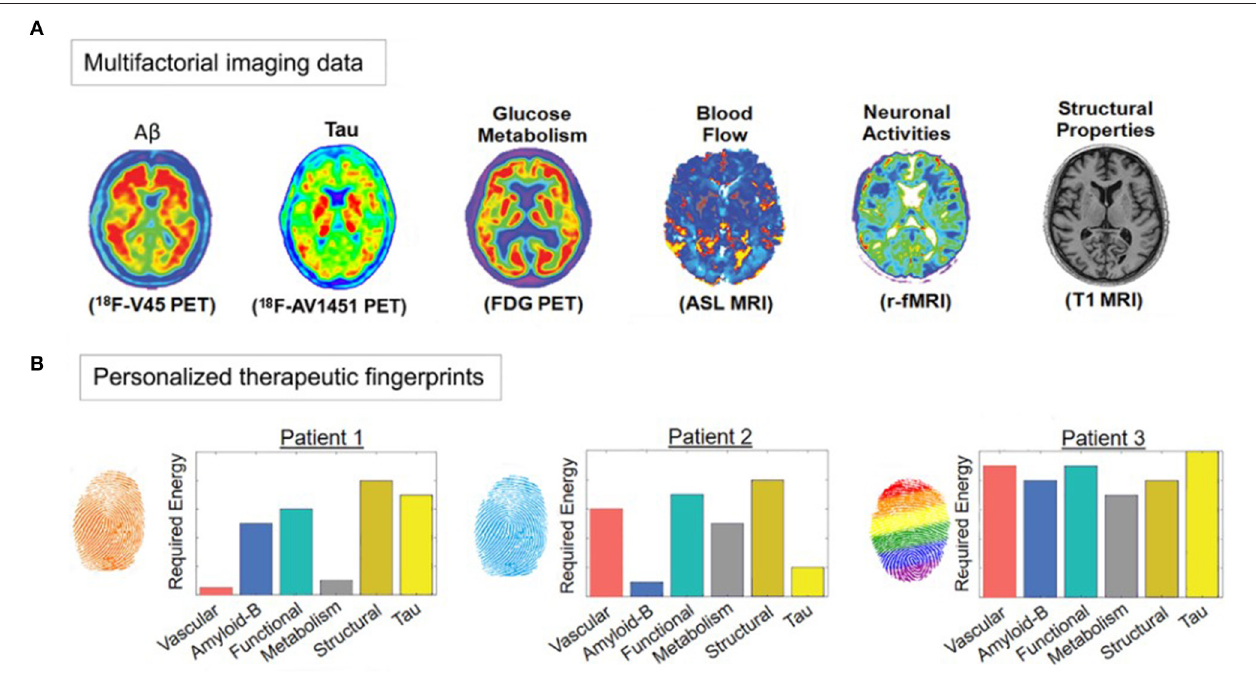
FIGURE 5 | Imaging-based therapeutic intervention fingerprinting approach (A) Amyloid, tau, and F-fluorodeoxyglucose (FDG) PET, and Cerebral Blood Flow (CBF), functional activity at rest and gray matter density from MRI. A network-based approach allows individual characterization of the intra-brain direct factor-factor biological interactions and the spreading mechanisms through vascular/anatomical connections. Inverting the model’s equations allow estimation of the optimum required to produce a desired clinical state (e.g., healthy). (B) Different pTIF patterns for three participants with similar clinical status. Note that Patient 1 requires lower cost-energy values for vascular and metabolic interventions, while Patient 2 requires lower values for anti-Aß and anti-tau interventions, suggesting the identification of specific single-target therapies that may benefit these patients (e.g., physical exercise and aducanumab, respectively). However, Patient 3 requires high cost-energy for all the single-target interventions, suggesting that combinatorial (and not single-target) treatments will be most beneficial. Image adapted with permission from Iturria-Medina et al.